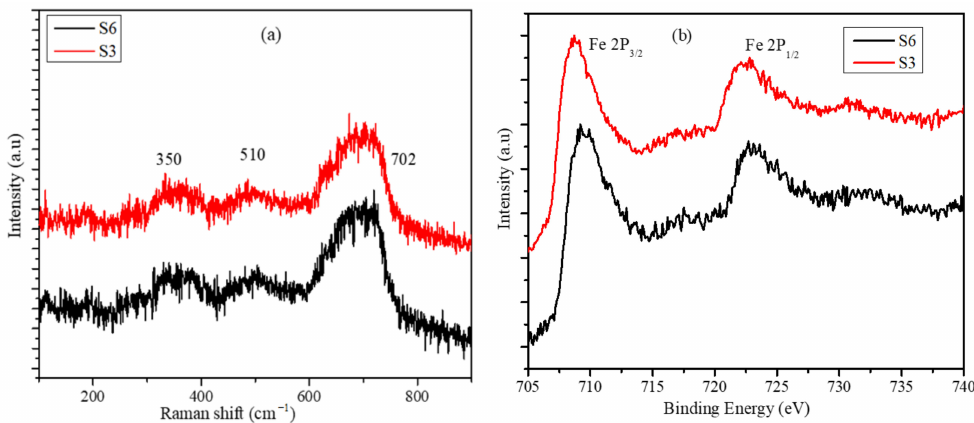
Figure 4. ( a ) Raman spectroscopy, and ( b ) XPS-binding energy profiles of S6 and S3